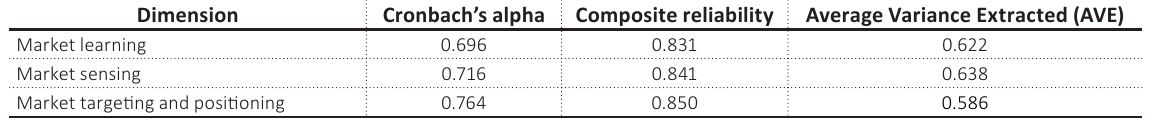
Table A1. Construct reliability and validity